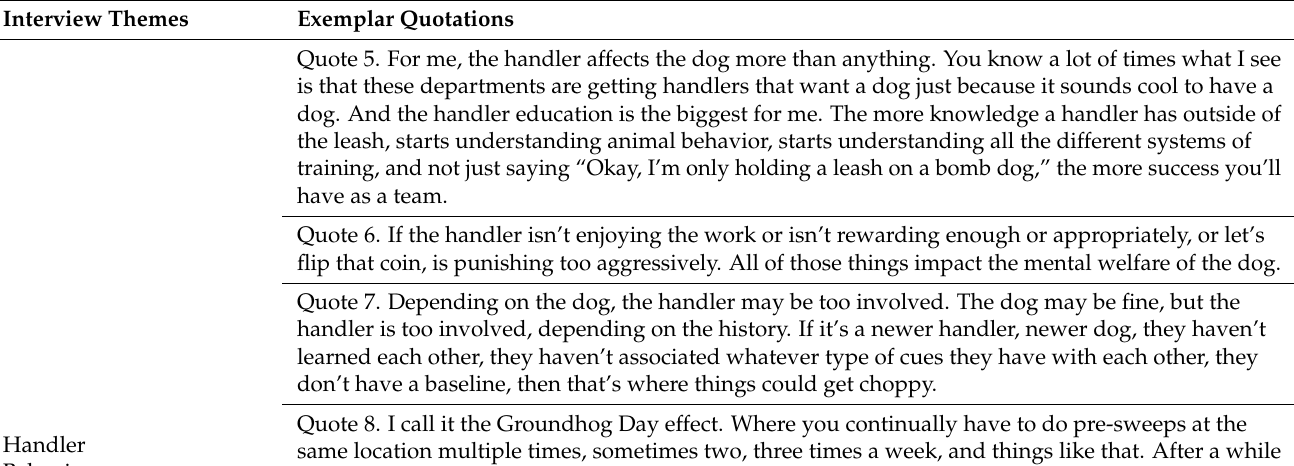
Table 2. EDC team factors—handler behavior themes and exemplar